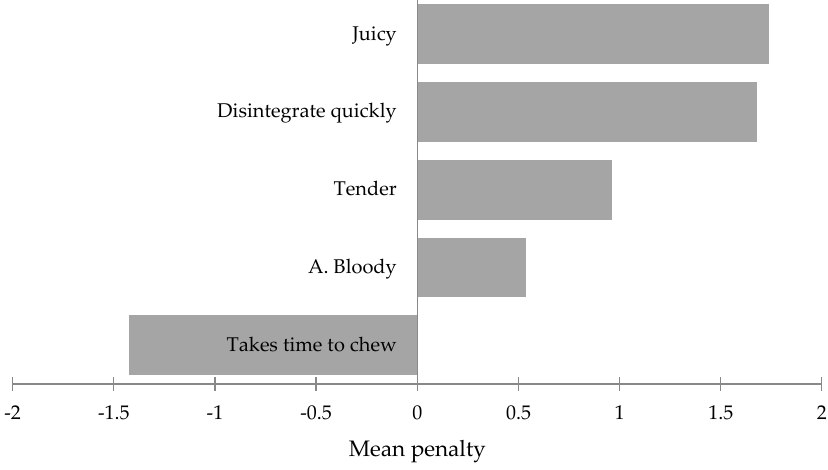
Figure 3. Mean penalties associated with specific attributes (A. — Aroma).